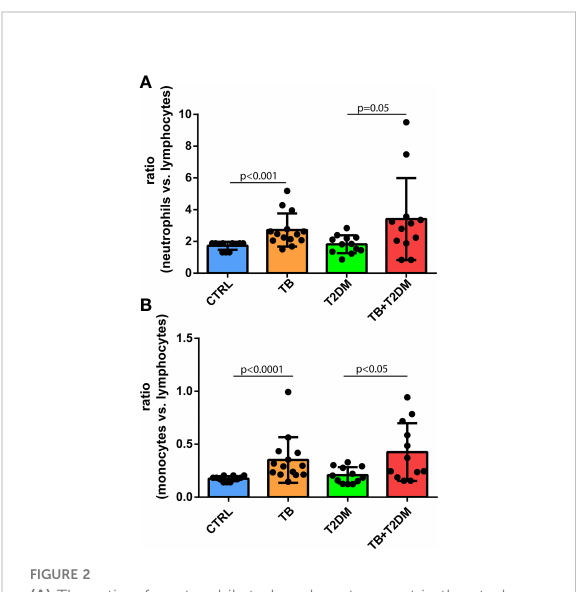
FIGURE 2 (A) The ratio of neutrophils to lymphocyte count in the study subjects; (B) The ratio of monocyte number to lymphocyte count in the study